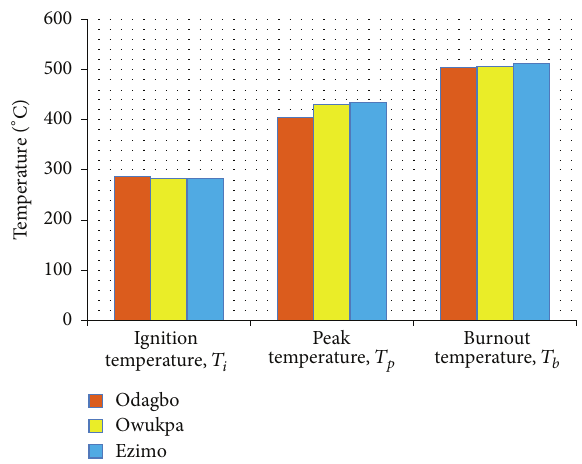
Figure 4: Characteristic temperatures of the coal samples.